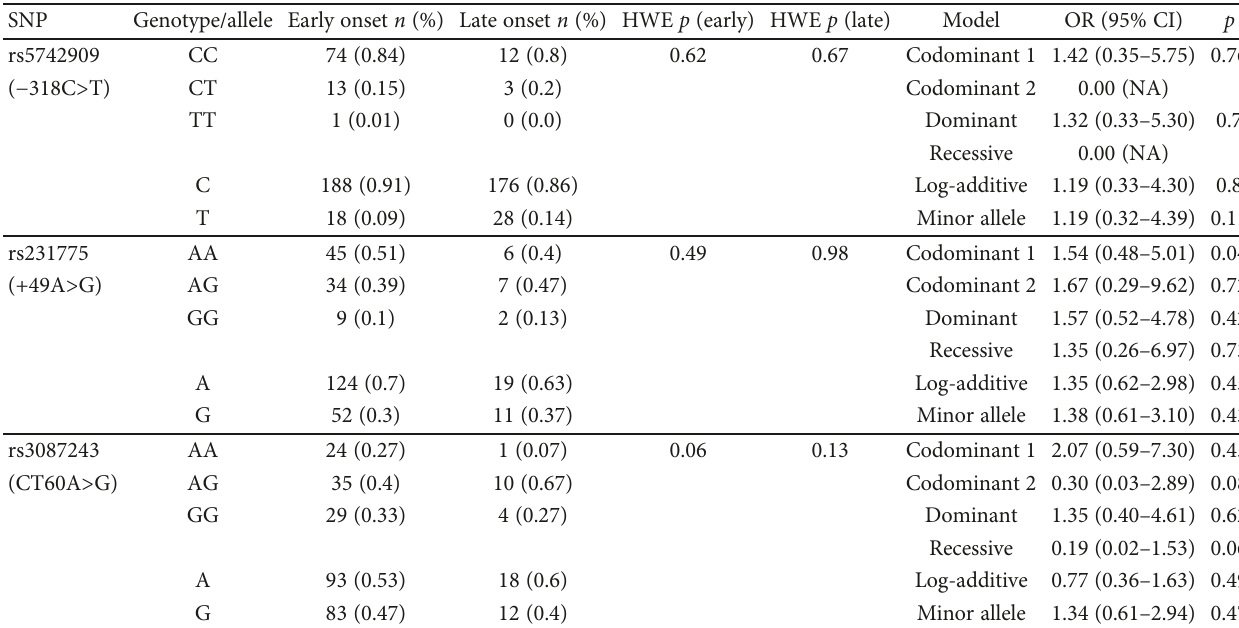
Table 4: Genotype and allele frequencies of CTLA-4 gene polymorphisms in the early-onset subgroup and late-onset subgroup and the association of these polymorphisms with onset age of Pv.